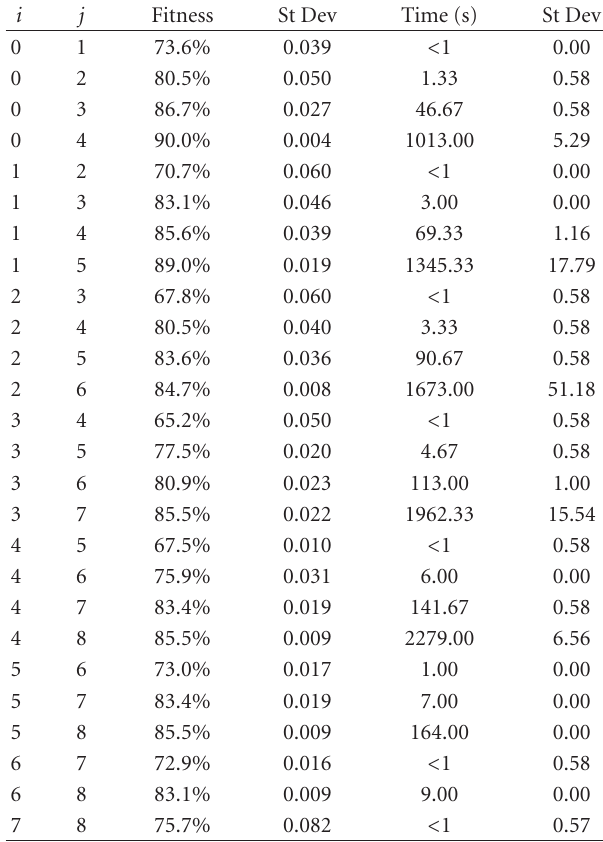
Table 5: Results for the DFS-BT across all folds on the Bos Wars Training